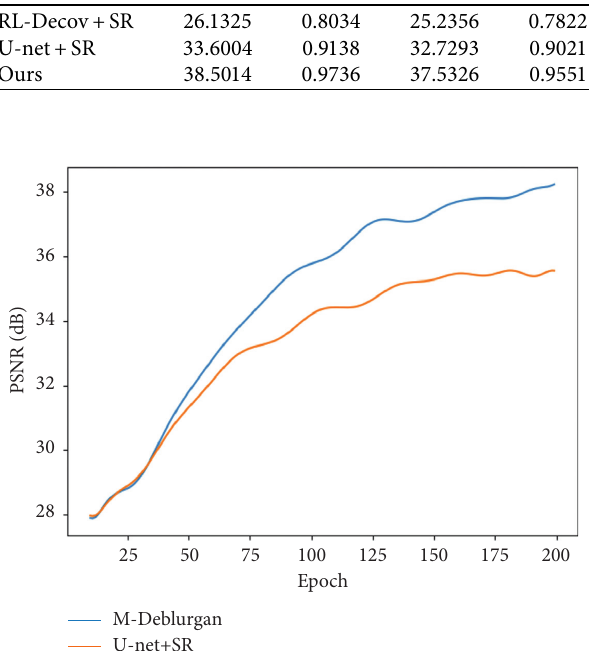
Figure 6: Quantitative analysis of two different deep learning methods on the training process.